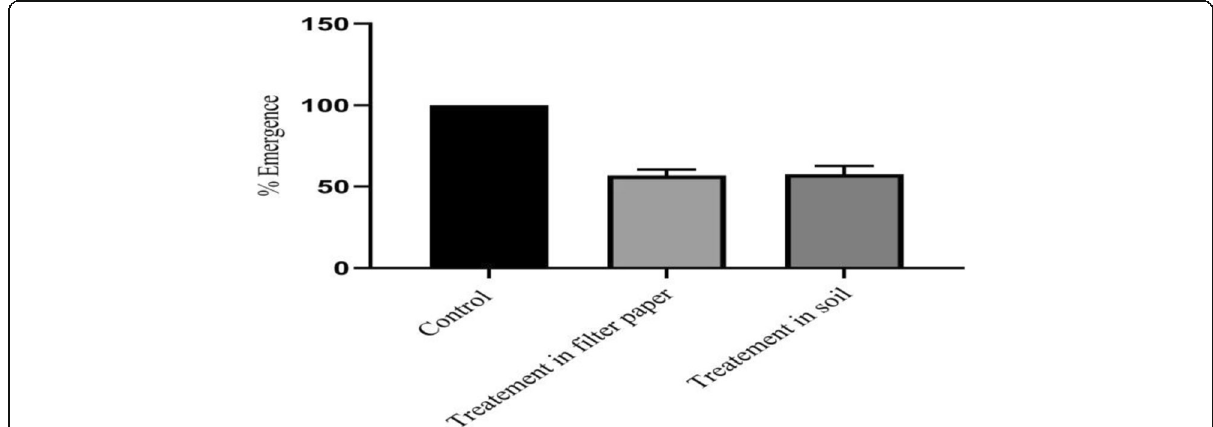
Fig. 2 Emergence rates (means + SE) of Ceratitis capitata pupae treated with Beauveria bassiana suspension at 10 7 conidia/ml. a Soil application.